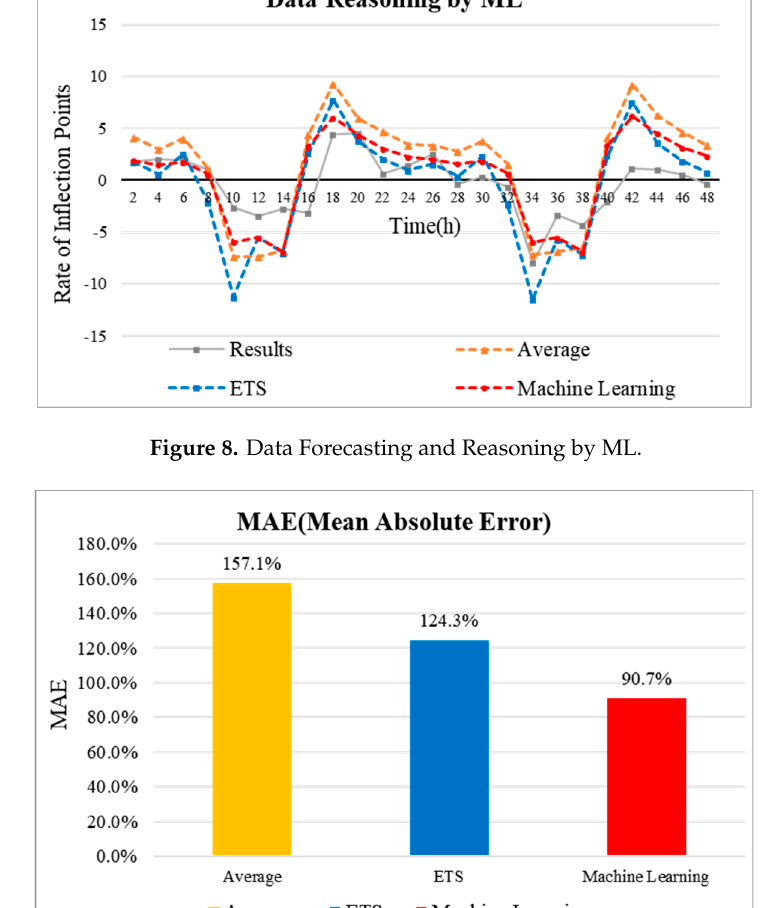
Figure 9. Error Rate by MAE (Mean Absolute Error) Method.